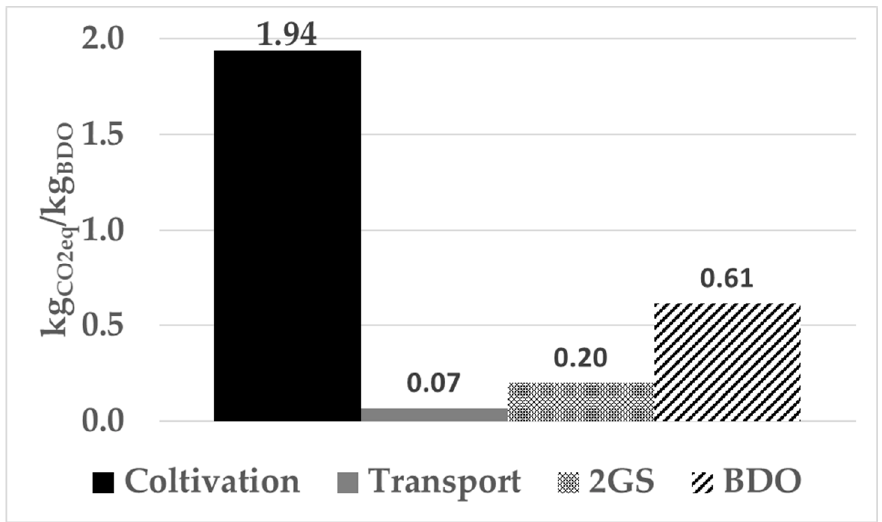
Figure 5. Distribution of environmental impact of cultivation, transport, 2GS production, BDO production